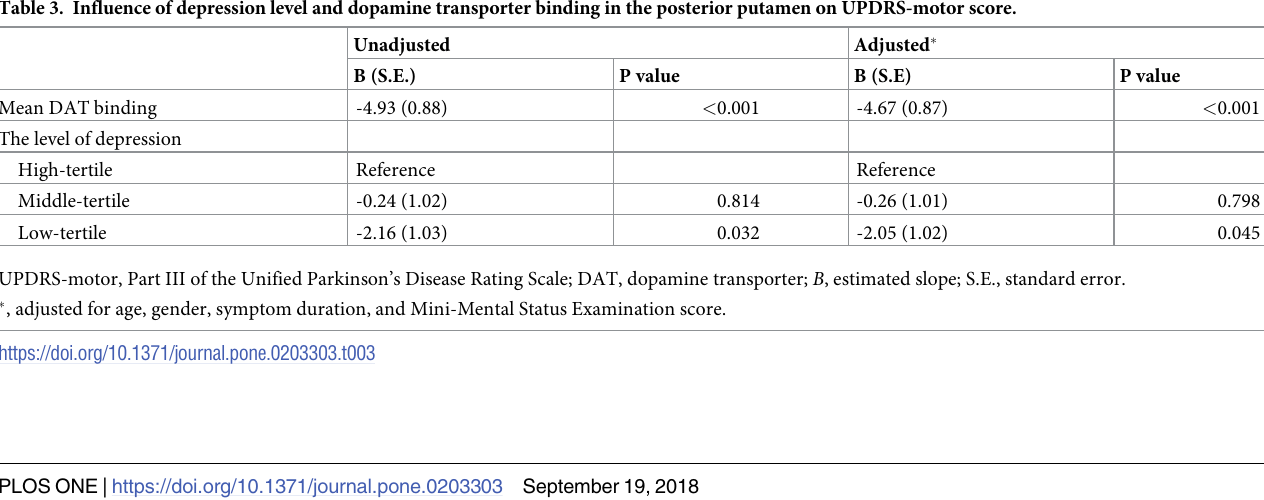
Data are means ± SDs.